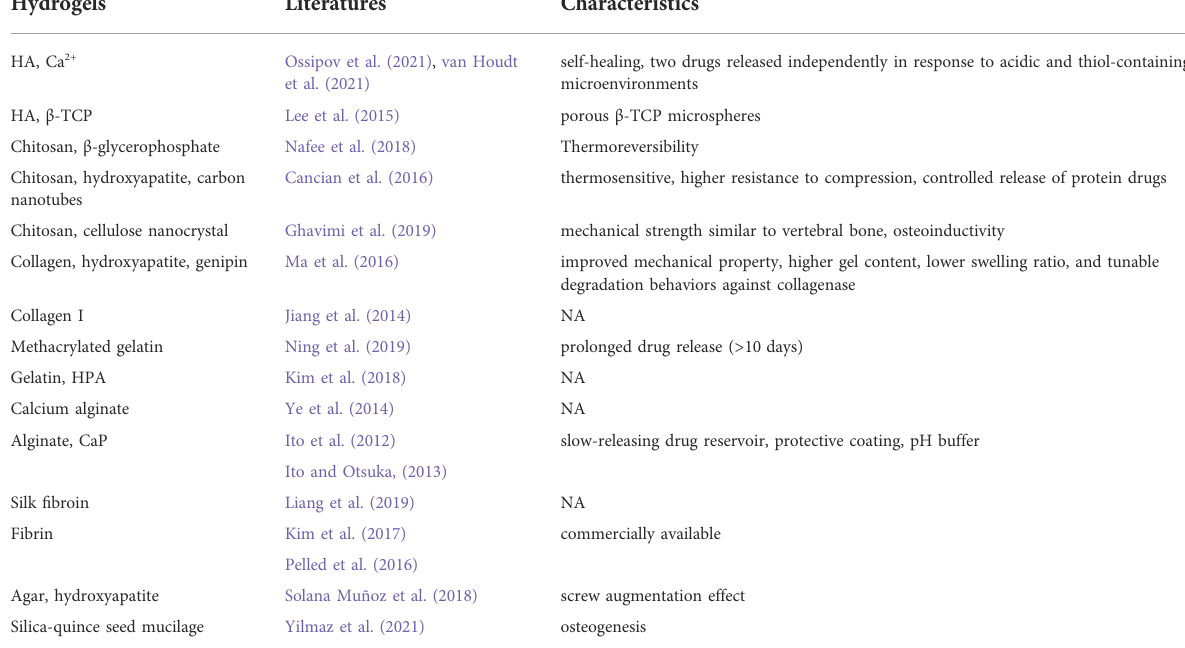
TABLE 1 Components and characteristics of nature-based